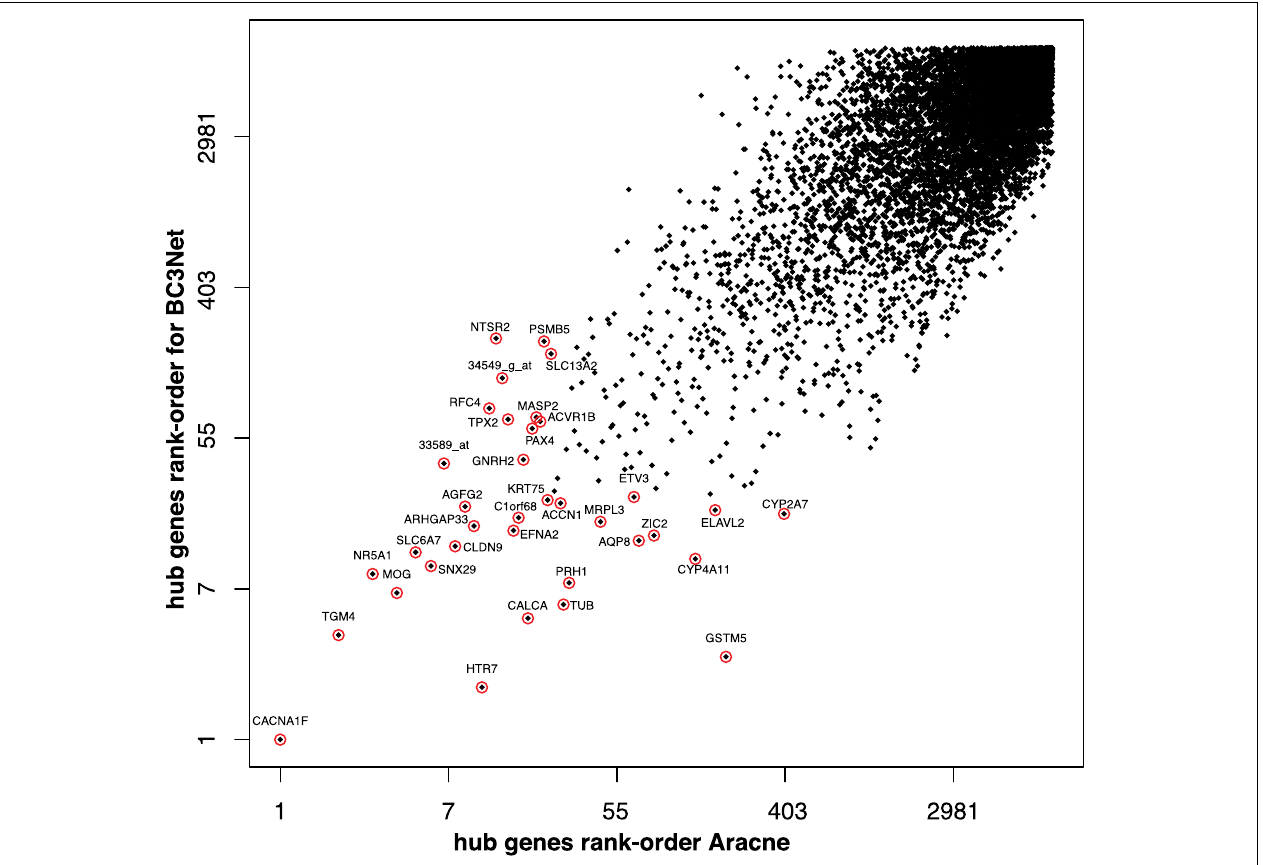
FIGURE 4 | Comparison of the rank-order of hub-genes for BC3Net (y-axis) and Aracne (x-axis). The axis are log-transformed for a better visualization. The red circles correspond to the top hub genes for Aracne and BC3Net.